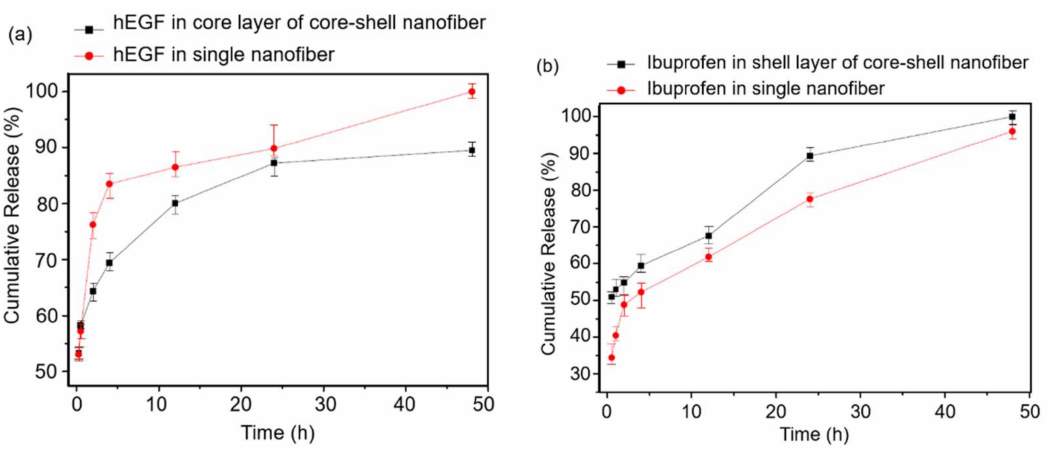
Figure 9. Drug release profiles of ( a ) hEGF and ( b ) ibuprofen in the core-shell and monoaxial